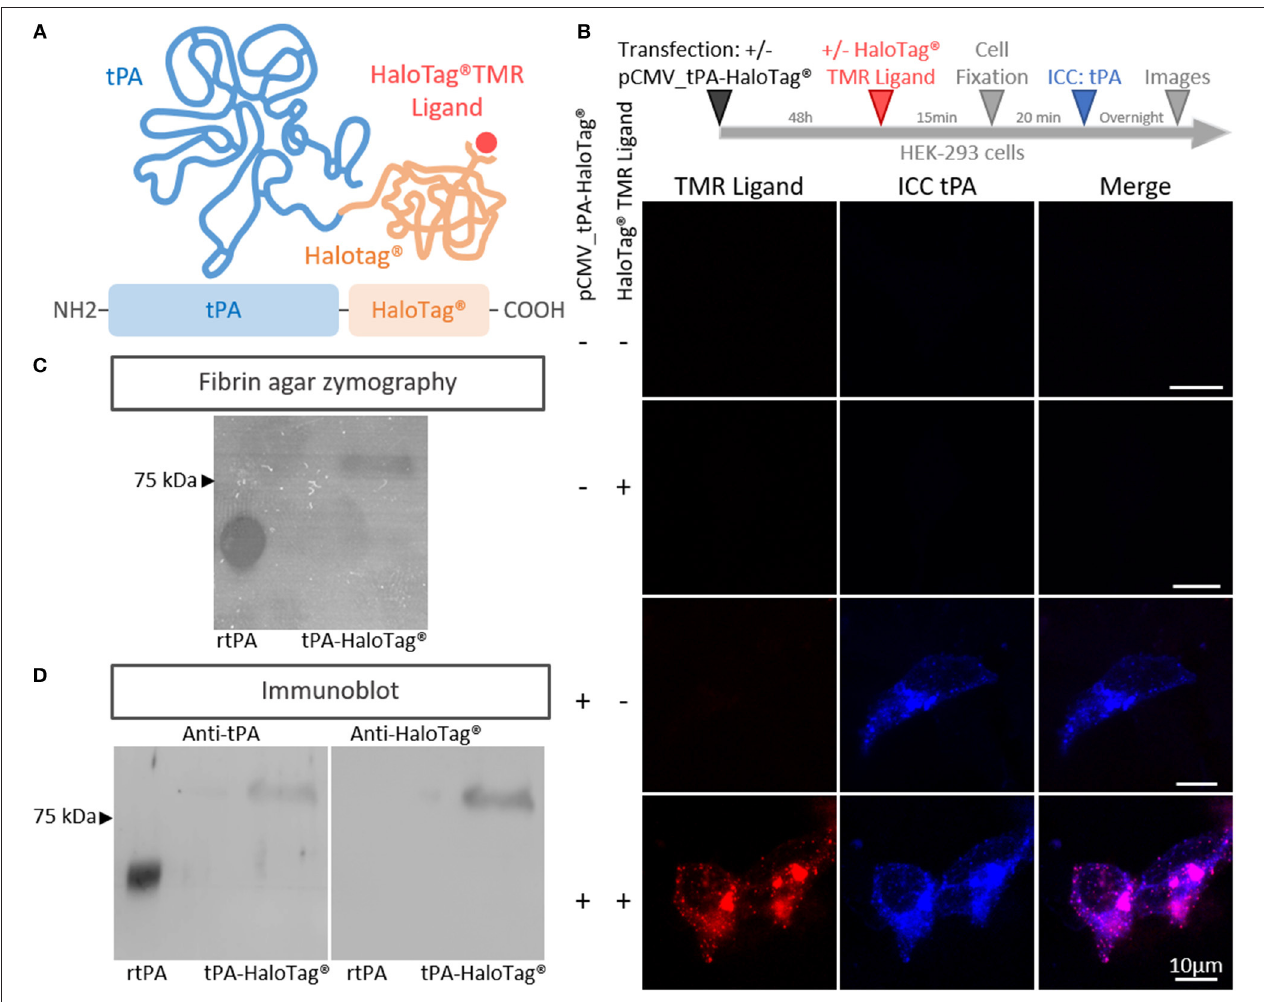
FIGURE 1 | Generation of the tPA-HaloTag ® . (A) Scheme of the tPA-HaloTag ® protein: tPA in blue (69 kDa), HaloTag ® in orange (33 kDa) and the specific fluorescent exogenous ligand (HaloTag ® TMR Ligand) in red. (B) Representative confocal images of HEK-293 cells transfected ( + ) or not (–) with pCMV_tPA-HaloTag ® , incubated 48h later ( + ) or not (–) in the presence of the HaloTag ® TMR ligand, followed by immunocytochemistry (ICC) raised against tPA (blue). Scale Bar: 10 µ m. (C) Fibrin–agar zymography showing the fibrinolytic activity of recombinant tPA (rtPA) as control and tPA-HaloTag ® produced by HEK 293 transfected cells. (D) Immunoblots of recombinant tPA (rtPA) and proteins from HEK-293 cells culture transfected with pCMV_tPA-HaloTag ® revealed with antibodies raised against either tPA or HaloTag ® . Control tPA (rtPA).